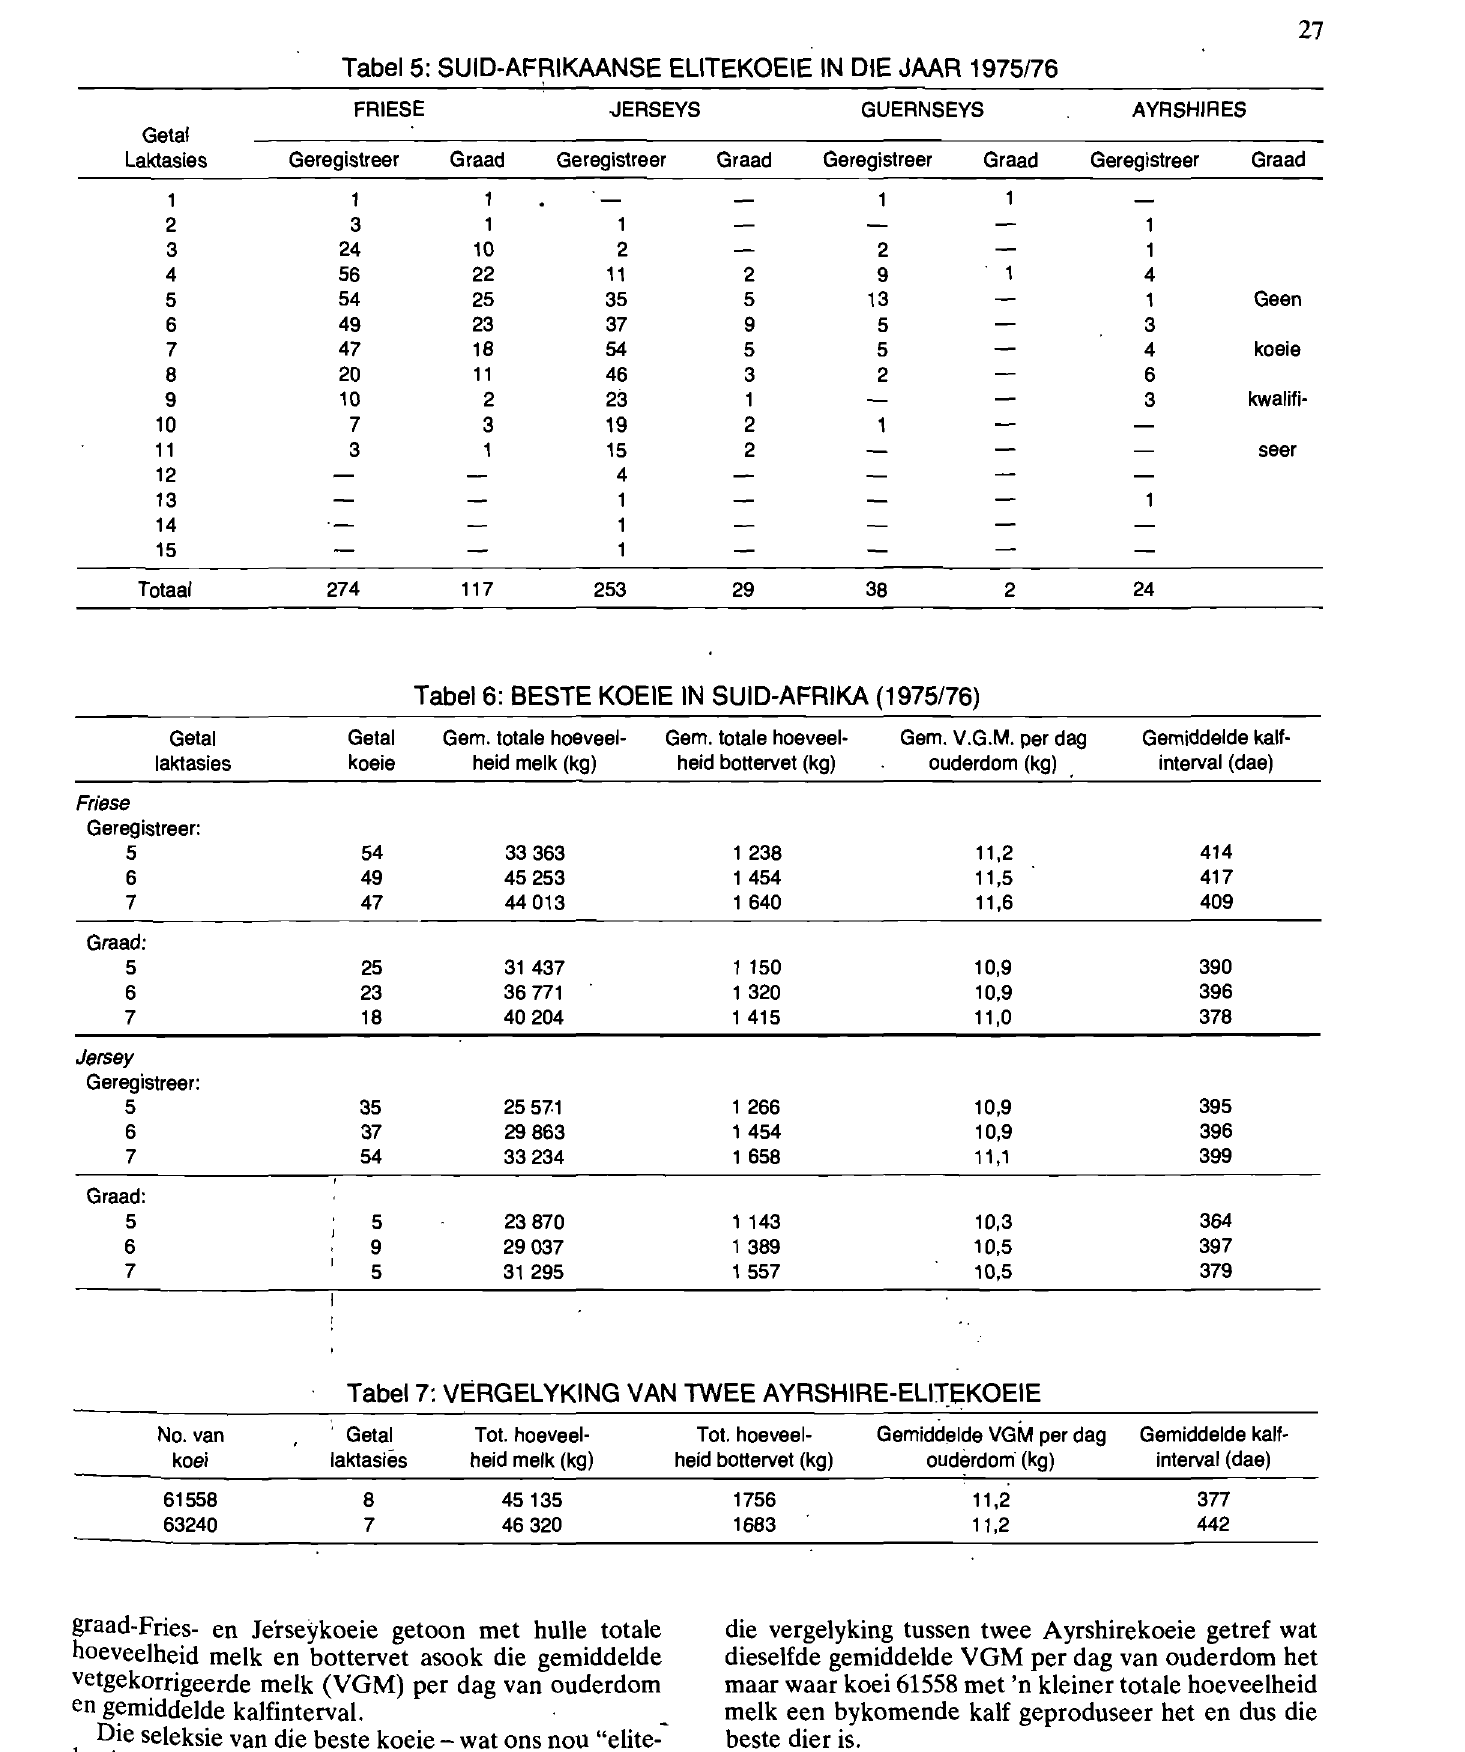
Tabel 5: SUID-AFRIKAANSE ELiTEKOEIE IN DIE JAAR 1975/76